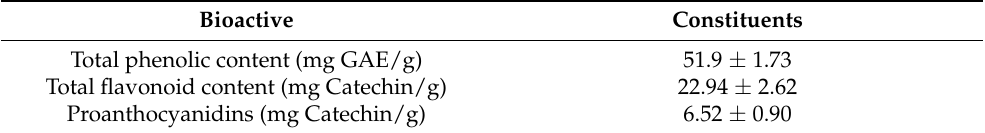
Table 1. Bioactive compounds of